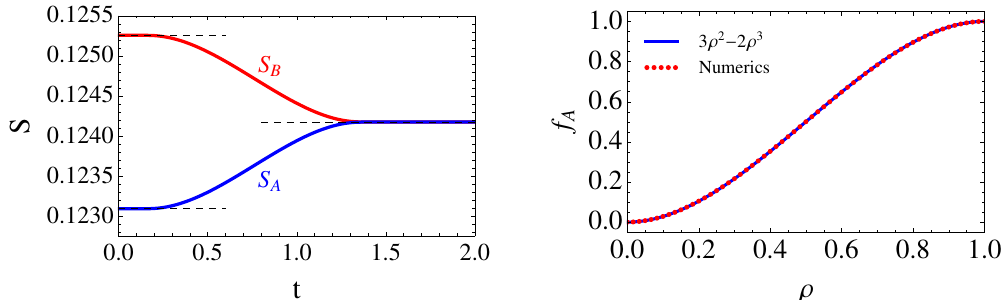
Figure 7 . (Left) Renormalized entanglement entropies of intervals A and B as a function of time, see (cid:12)gure 4. The intervals correspond to x A 2 [0 : 175 ; 1 : 35] and x B 2 [ (cid:0) 1 : 35 ; (cid:0) 0 : 175], and temperatures T L = 0 : 2 and T R = 0 : 195. The (dashed) horizontal lines correspond to the results by using the analytical formulae (3.16) and (3.17). We have set G = 1 and L = 1. (Right) Renormalized entanglement entropy S A as a function of time, normalized to [0 ; 1] in both horizontal and vertical axes, see (3.9). The dots correspond to the numerical result with the interval A in (cid:12)gure 4, while the continuous line is the universal behavior f A ( (cid:26) ) = 3 (cid:26) 2 (cid:0) 2 (cid:26) 3